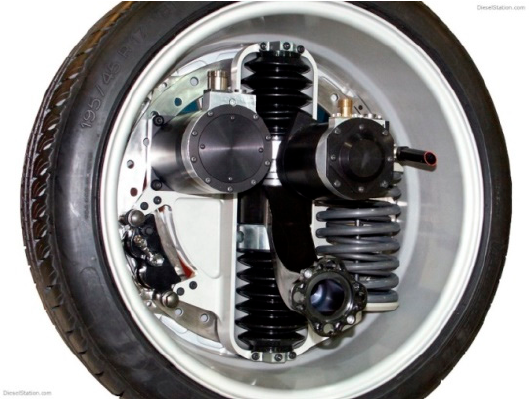
Figure 2. Motor-wheel of an electric vehicle.